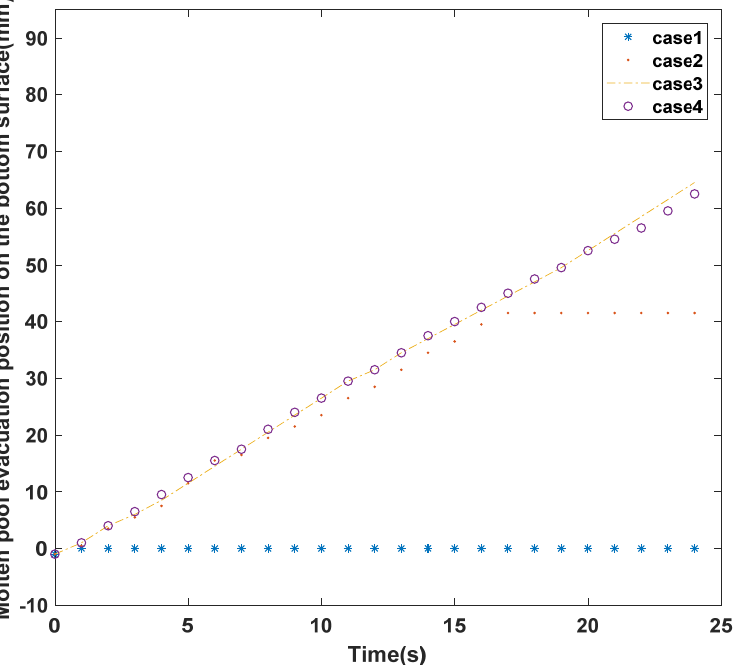
Figure 9. Location of molten pool evacuation on the bottom surface along the x-direction for a variable time.